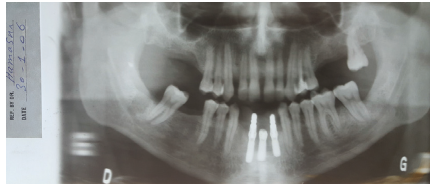
Figure 3: Panoramic X-ray after 3 months of first visit showing bone formation at the site of extracted molars and bone stability around Straumann mandibular implants.